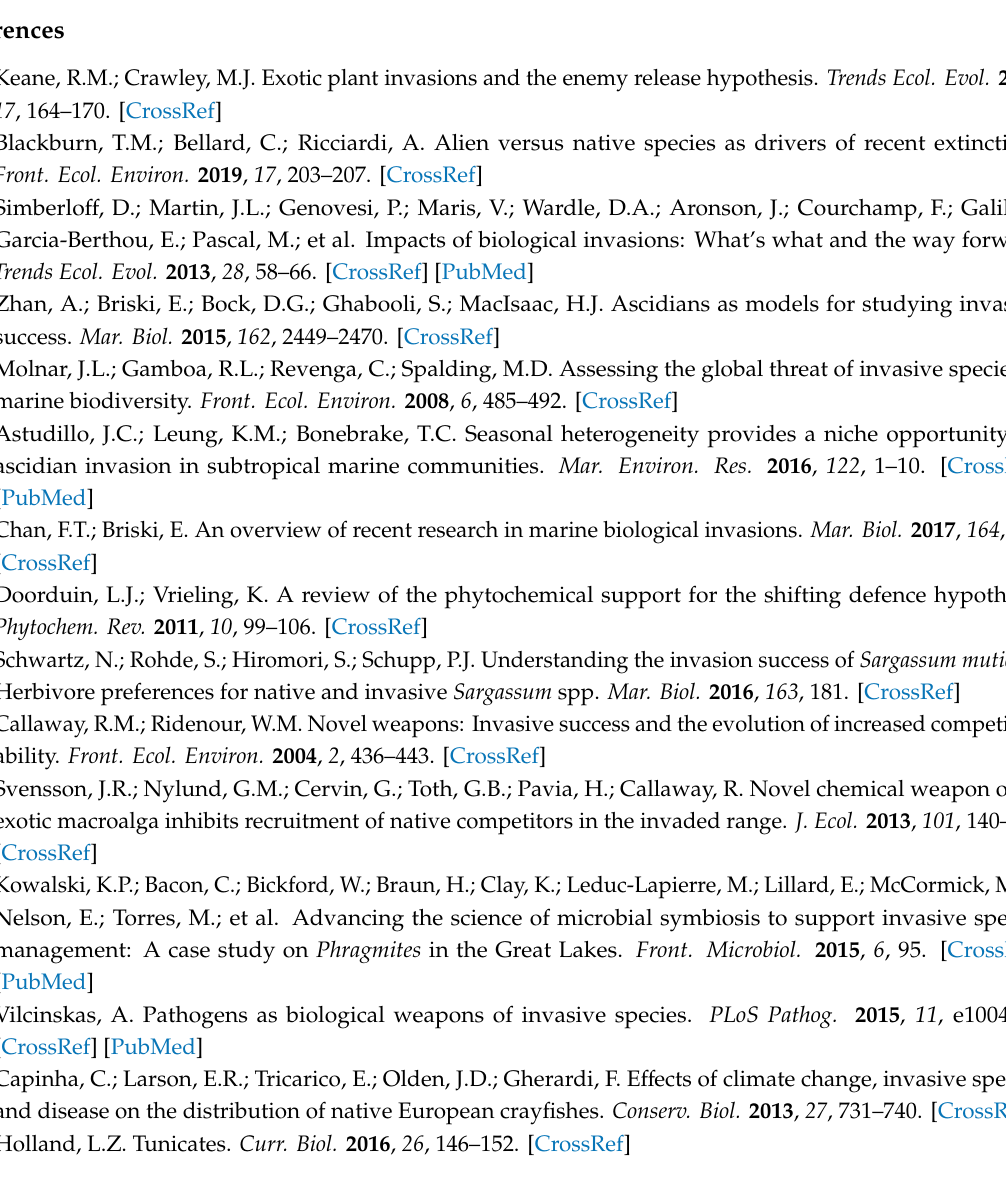
Table S8: Significantly di ff erent abundant bacterial classes, families and genera, Table S9: Significantly di ff erent abundant OTUs, Table S10: Classification of abundant OTUs detected in this study, Table S11: Putative annotation of metabolites detected in C. intestinalis bulk extracts (population level), Table S12: ANOSIM comparison of UPLC-MS / MS profiles of C. intestinalis